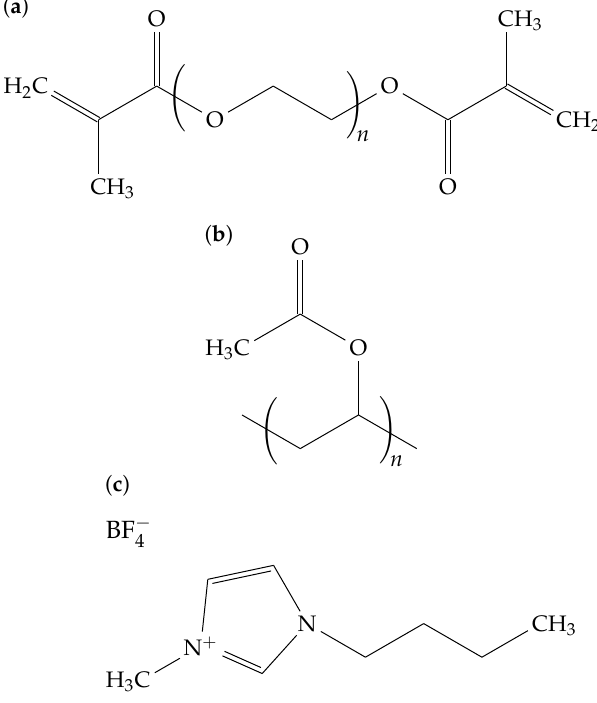
Figure 1. Structures of the components used: ( a ) PEGDMA, ( b ) PVAC, and ( c ) BMIMBF 4